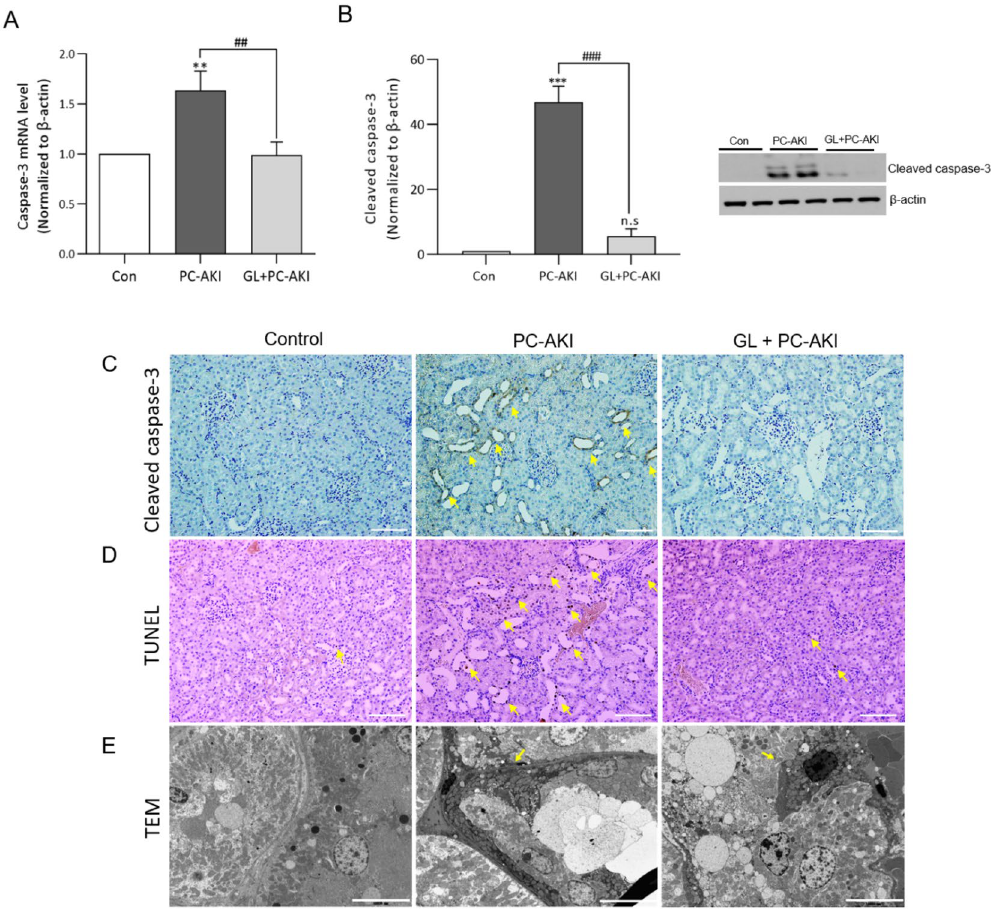
Figure 5. Glycyrrhizin-mitigated apoptosis by PC-AKI. Relative expressions of caspase-3 mRNA (A) and protein levels of cleaved caspase-3 (B) were significantly increased in the PC-AKI group compared to the controls, whereas they were significantly lower in the PC-AKI with glycyrrhizin group than the PC-AKI group. (C-D) The immunohistochemistry of cleaved caspase-3 and TUNEL indicated apoptotic cells (arrowheads) in the PC-AKI group. Magnification = 20X, Scale bar = 100 μm. (E) TEM images shows that the area of apoptosis (arrows) in the kidney tissue of PC-AKI is wider than that of the PC-AKI with glycyrrhizin group. Magnification = 3 K, Scale bar = 5000 nm. Images of blots were cropped. Full-length blots are presented in Supplementary Figure 1. Statistical significance: ** P < 0.01 and *** P < 0.001 Con vs PC-AKI, ## P < 0.01 and ### P < 0.001 PC-AKI vs PC-AKI + GL. Abbreviation: PC-AKI, post-contrast acute kidney injury; GL, glycyrrhizin; TEM, transmission electron microscopy; TUNEL, Terminal deoxynucleotidyl transferase (TdT)- mediated dUTP